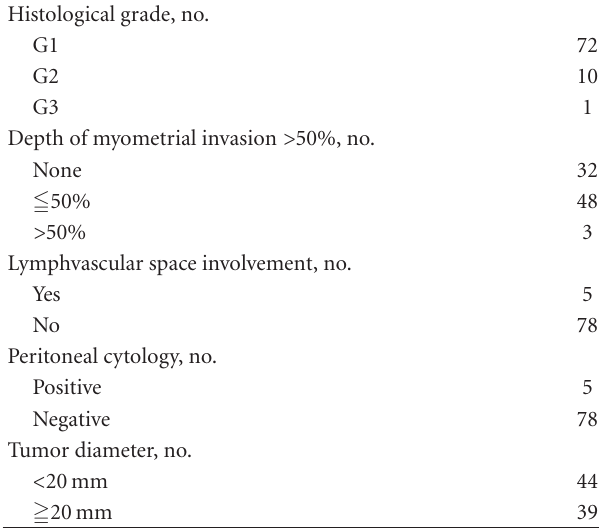
Table 2: Characteristics of the histopathological prognostic features ( n =